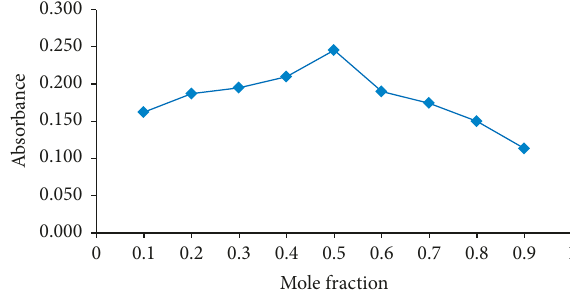
5 ) and Fe 3+ (2.6 5 10 10 × × − −